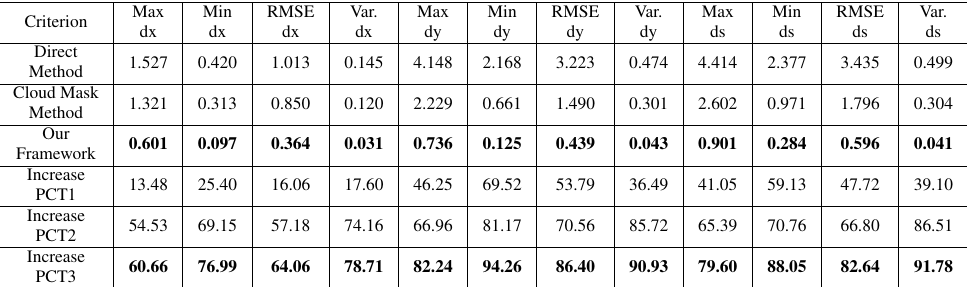
Table 2. Comparison of “direct method”, “cloud mask method” and our framework in 83 cloudy images. (Accuracy unit: pixel). Max dx, dy and ds are the max errors among all images in x-direction, y-direction and plane respectively, while Min dx, dy and ds are the opposite. Var. means the variance. Increase PCT1,PCT2,PCT3 are the percentage increase in “cloud mask method” relative to the “direct method”,our method relative to the “cloud mask method”, and our method relative to the “direct method” respectively. Criterion